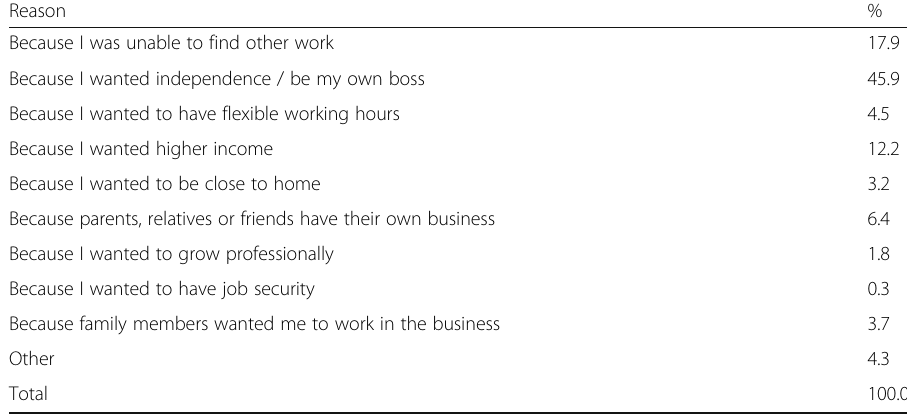
Table 3 Reasons for self-employment